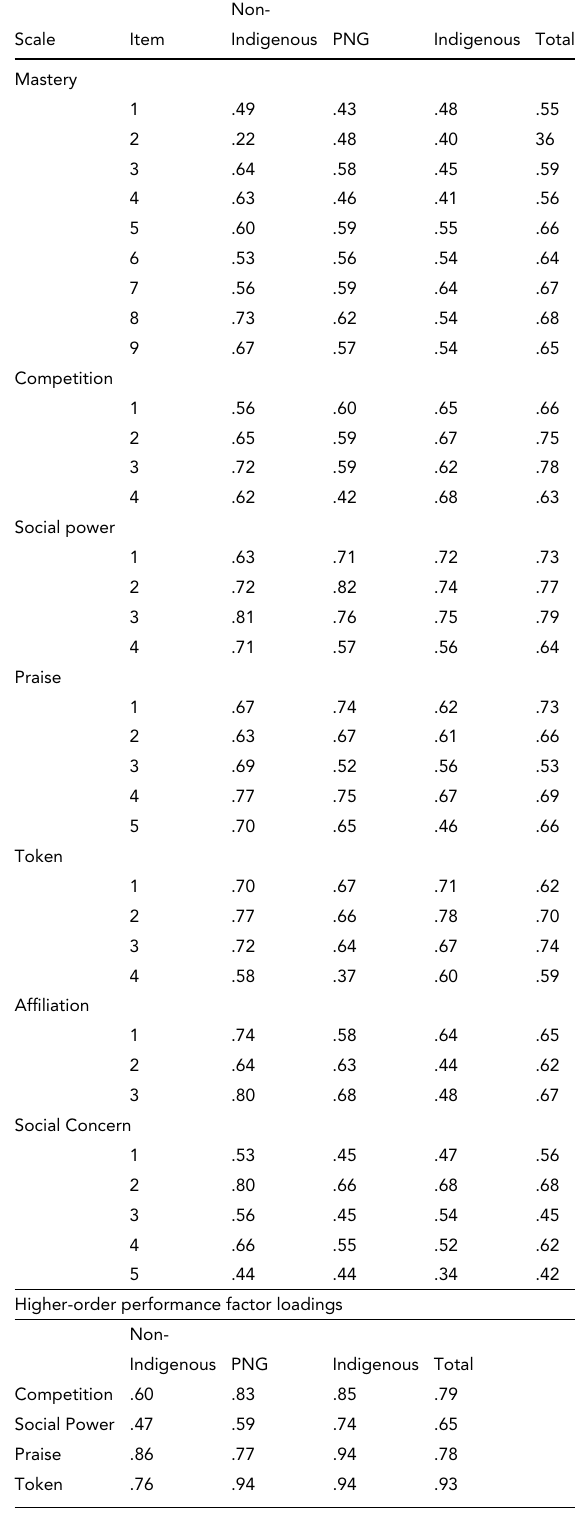
TABLE 2 Factor Loadings for the Subscales of the